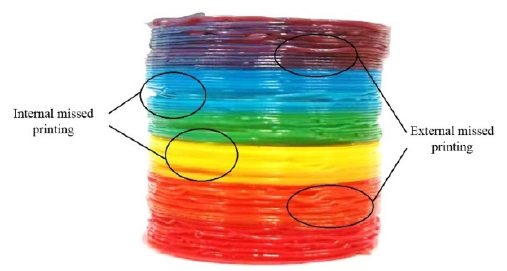
Figure 15. Internal missed printing and external missed printing. Table 3. The size error of the model before and after